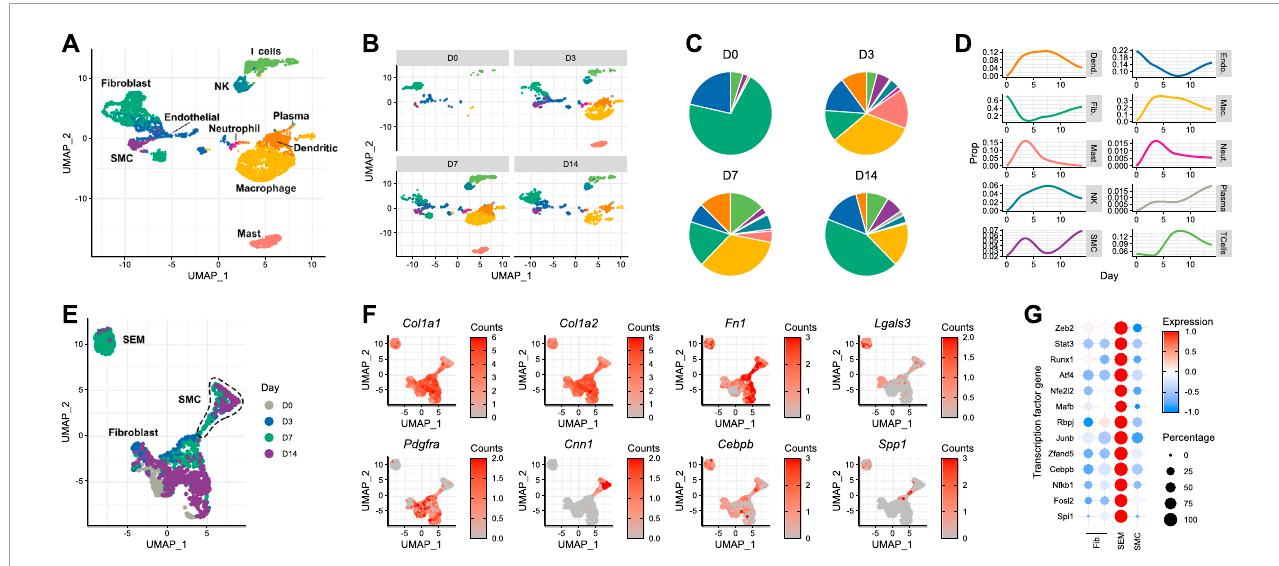
FIGURE 2 Response of the murine carotid artery to wire injury at single-cell resolution (A) UMAP plot of cells isolated from murine carotid arteries on days 0 (uninjured), 3, 7 and 14 after wire injury. (B) Cells isolated from carotid arteries, stratified by time point post-injury. (C) Cell type proportions at each time point post-injury, colour-matched to UMAP plots. (D) Time-resolved changes in cell type proportions. (E) Re-clustering of non-immune cells identified in carotid tissue before and after acute injury. (F) Gene expression of classical fibroblast ( Pdgfra ) and smooth muscle cell ( Cnn1 ) marker genes, as well as reported marker genes for stem cells/endothelial cells/monocyte (SEM) cells. (G) Scaled expression of genes encoding transcription factors in non-immune cell